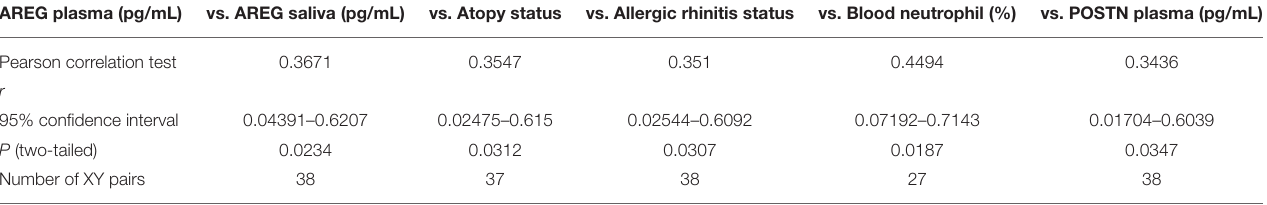
TABLE 4 | Correlation between plasma AREG concentrations, and the cohort demographics and laboratory tests. AREG plasma (pg/mL) vs. AREG saliva (pg/mL) vs. Atopy status vs. Allergic rhinitis status vs. Blood neutrophil (%) vs. POSTN plasma (pg/mL)